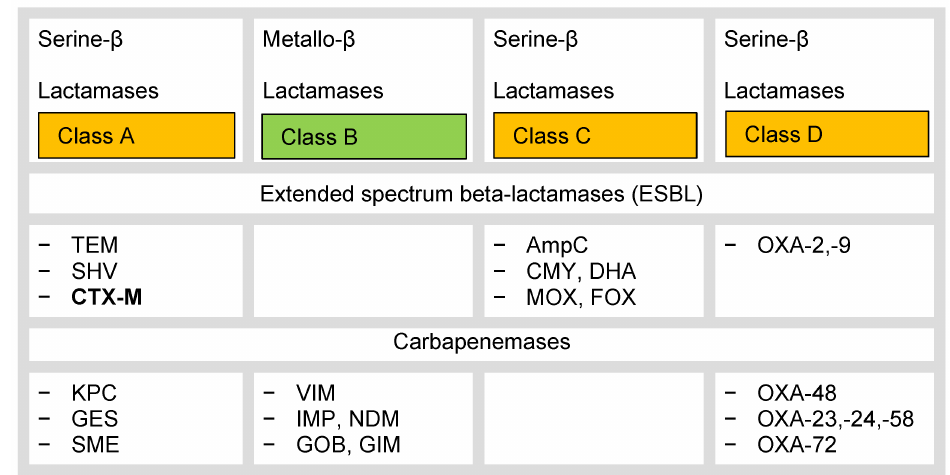
Figure 1: Classification of beta-lactamases, according to